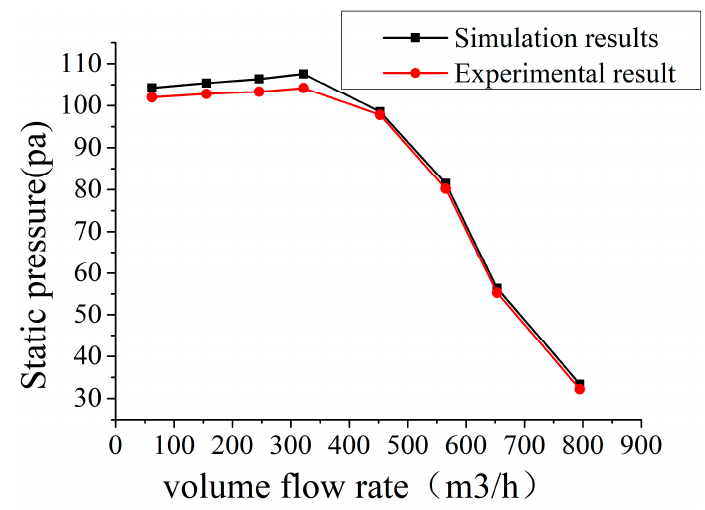
Figure 6. Comparison of experimental and numerical results under different volume flow rates.